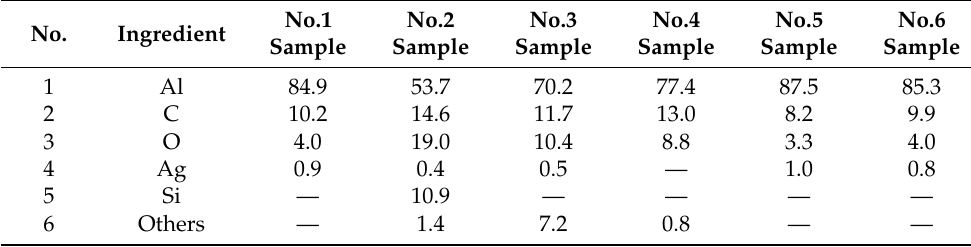
Figure 8. Typical surface energy spectrum of Al alloy. Table 2. Results of energy spectrum of No.1–No.6